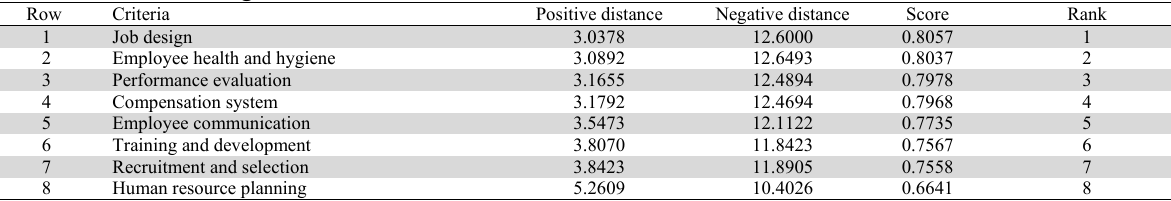
The results of ranking the main HRM